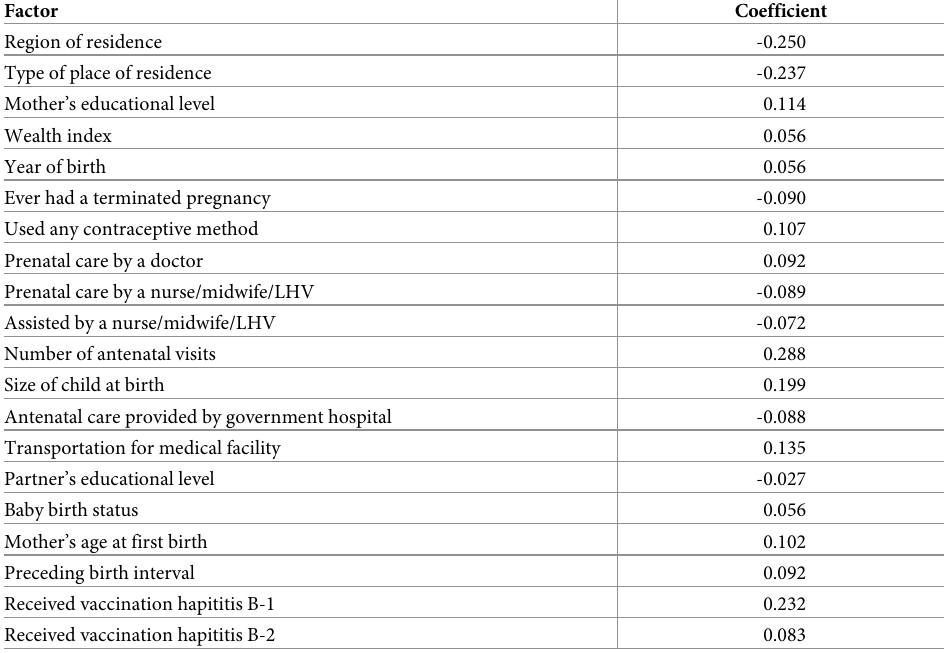
Table 2. CC-PLS coefficients are presented where inflectional factors are extracted by coupling CC-PLS with LW.